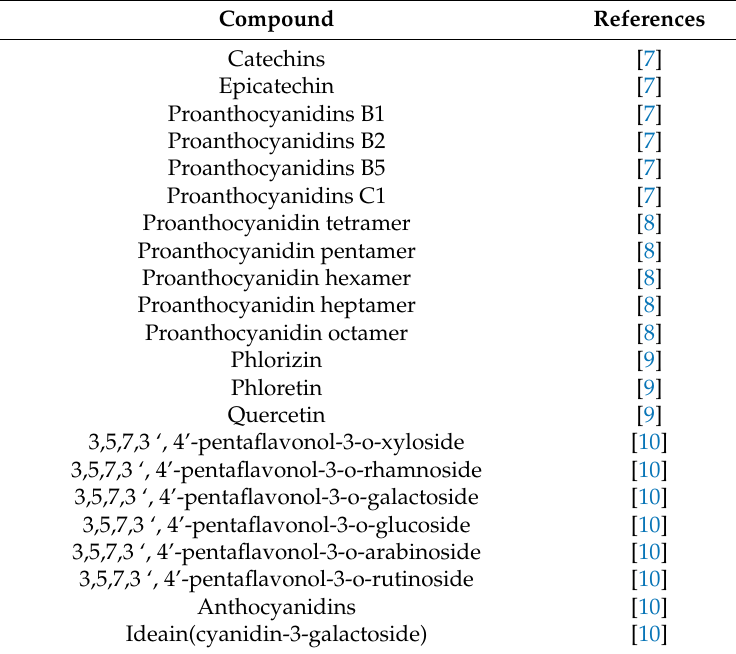
Table 3. The list of flavonoids isolated from apples.